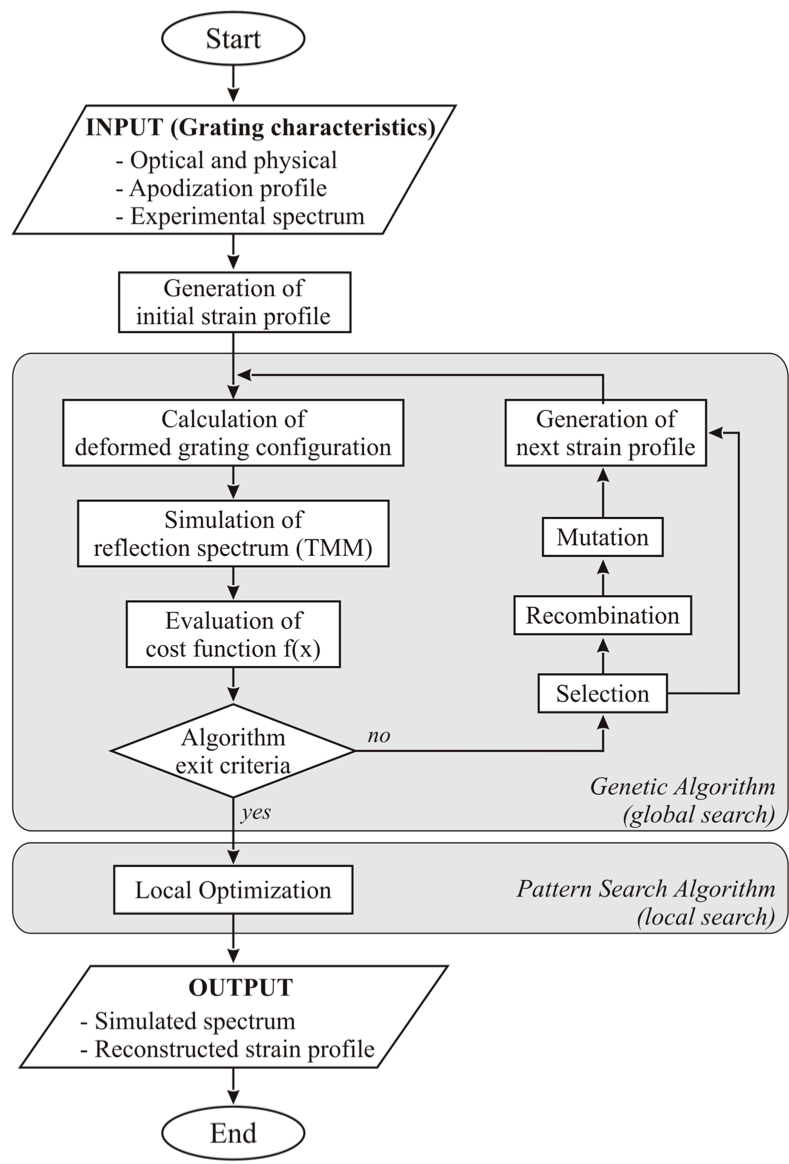
Figure 8. Method for spectral reconstruction proposed by Bettini et al. based on CFBG spectral analysis. Image from [57].